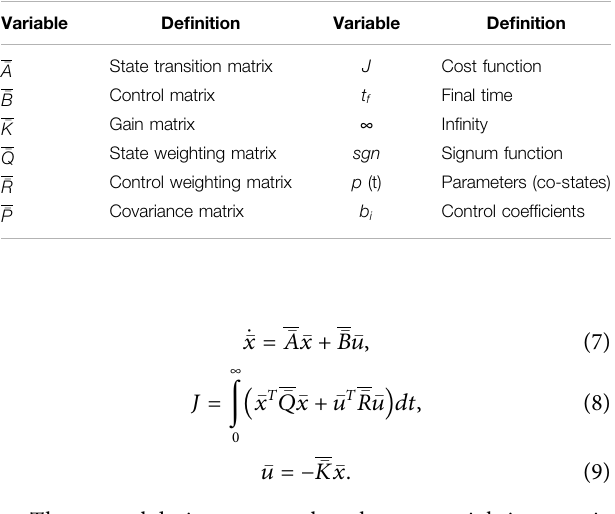
TABLE 2 | Proximal variable de fi nitions. TABLE 3 | Proximal variable de fi